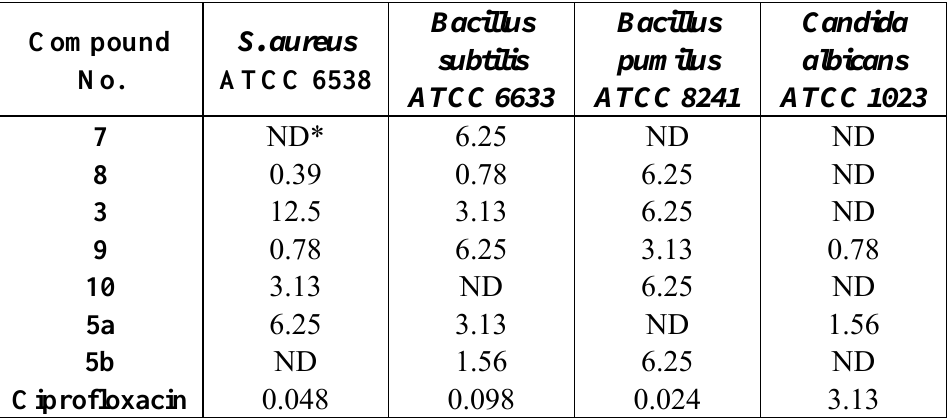
Table 1. MICs ( µ g/mL) for compounds 3 , 5 and 7-10 against Gram positive bacterial strains and Candida